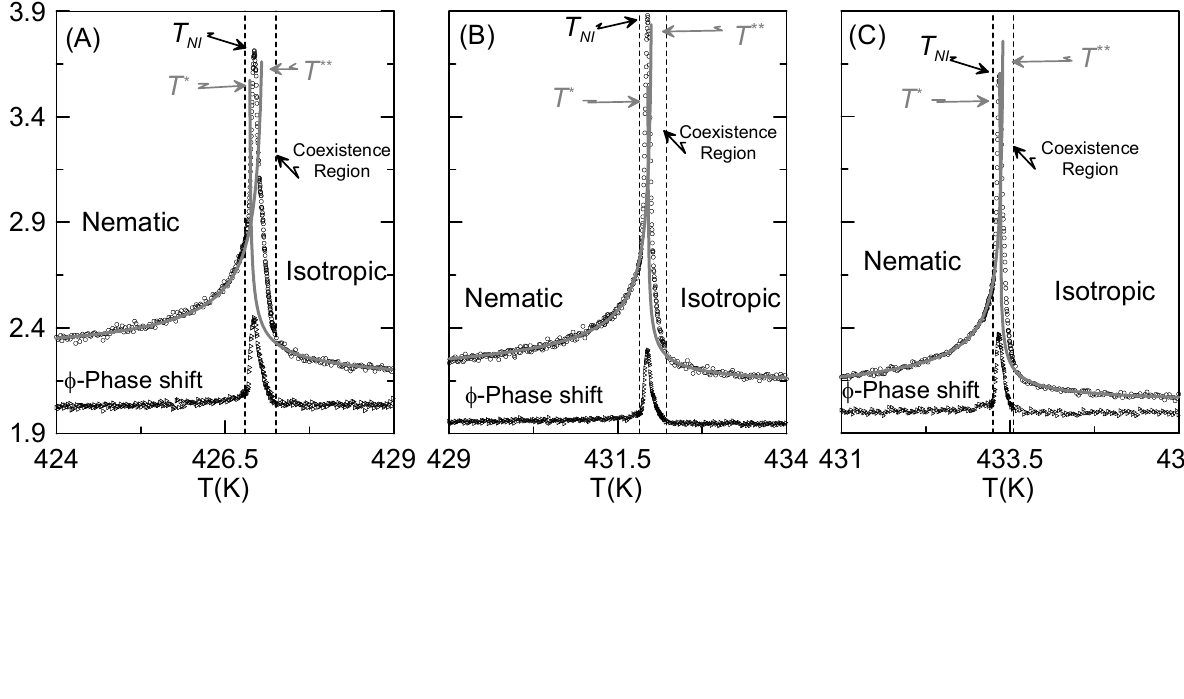
Figure 1. Specific-heat (circles) and Φ -phase shift (triangles) data as a function of temperature around the N–I phase transition. The gray lines show the fittings to equations (1a) and (1b). ( A ) CBO11O.Py; ( B ) CBO9O.Py; ( C )